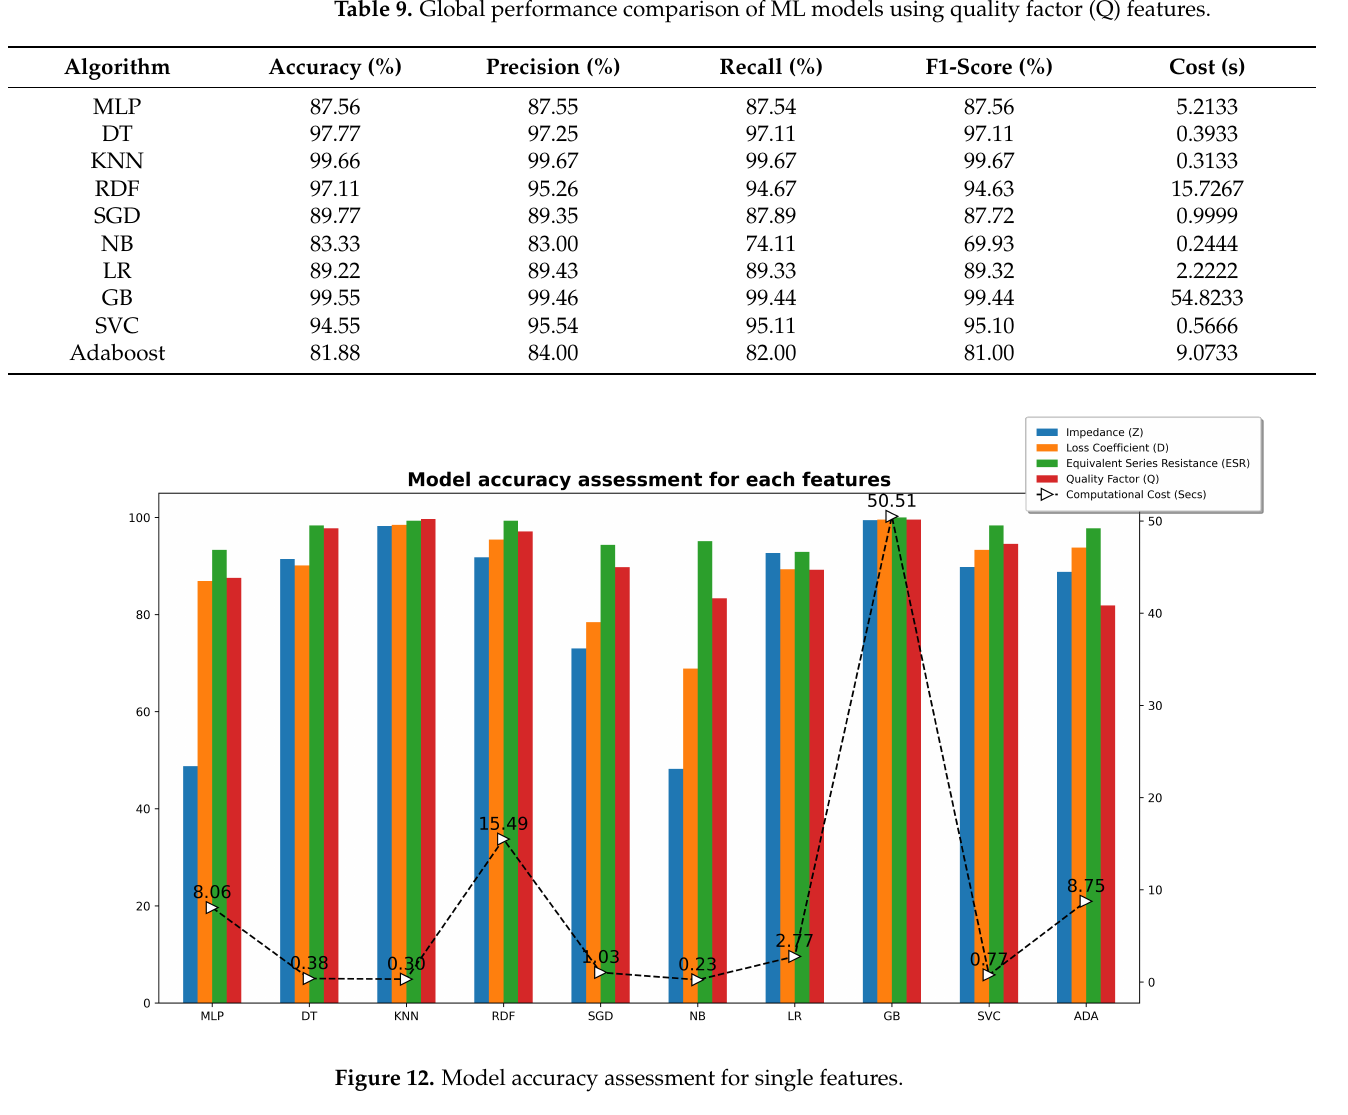
Table 9. Global performance comparison of ML models using quality factor (Q) features.